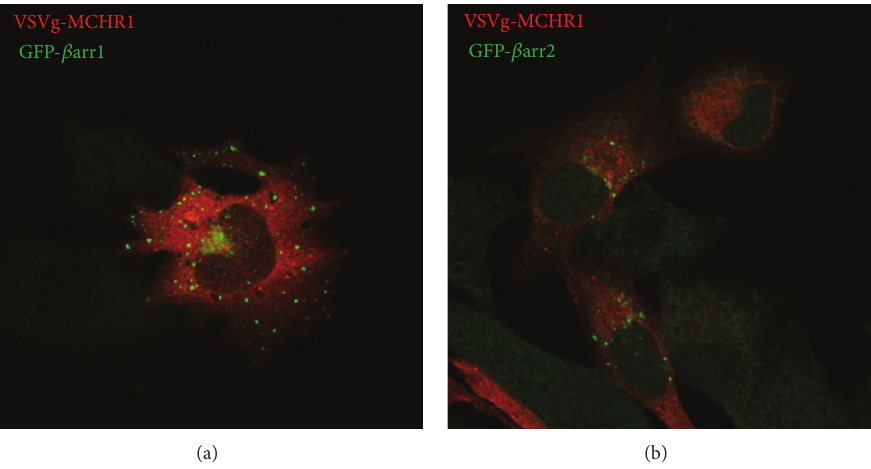
Figure 5: VSVg-MCHR1-containing vesicles are distinct from those associated with 𝛽 -arrestins. VSVg-MCHR1 and GFP 𝛽 -arrestin 1- expressing cells (a) and VSVg-MCHR1 and GFP 𝛽 -arrestin 2-expressing cells (b) were treated with 1 𝜇 M MCH for 30min, then fixed, and immunostained with anti-VSVg antibody. Confocal microscopy was performed using a grid pattern confocal microscope and Image-Pro Plus software. A single slice is shown as an overlay of both Alexa Fluor (546nm) and GFP (488nm) signals.